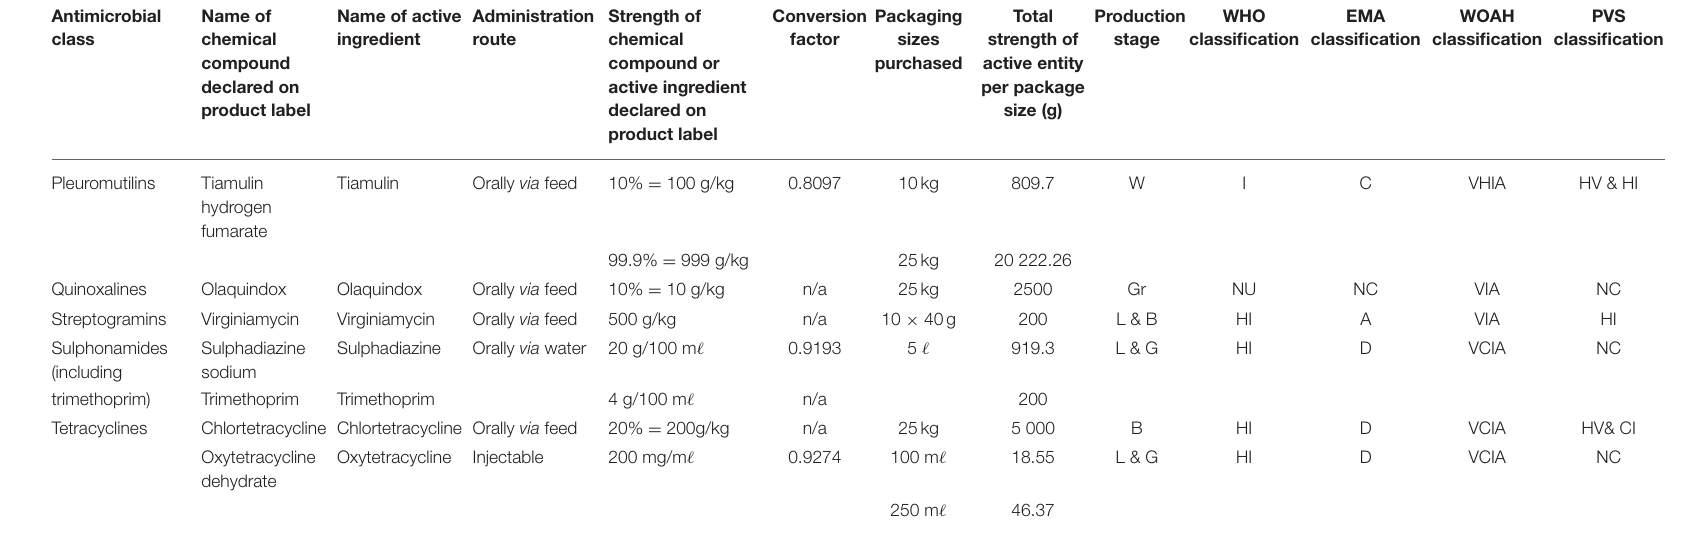
Supplementary Table 1 for the calculation of a conversion